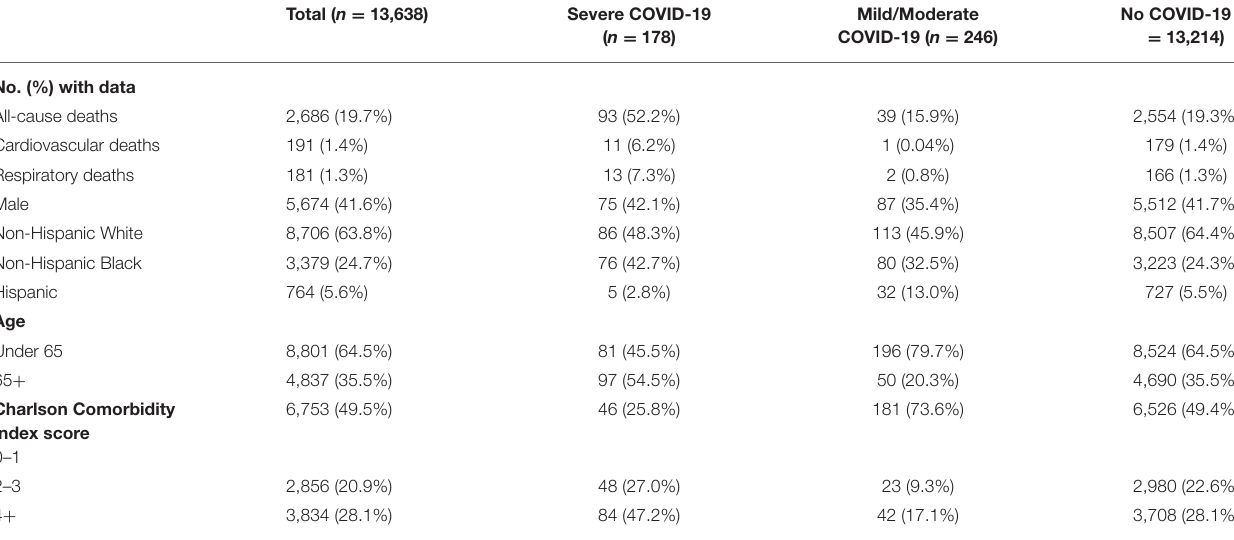
TABLE 2 | Characteristics of the COVID-19 positive and COVID-19 negative patients in the cohort.